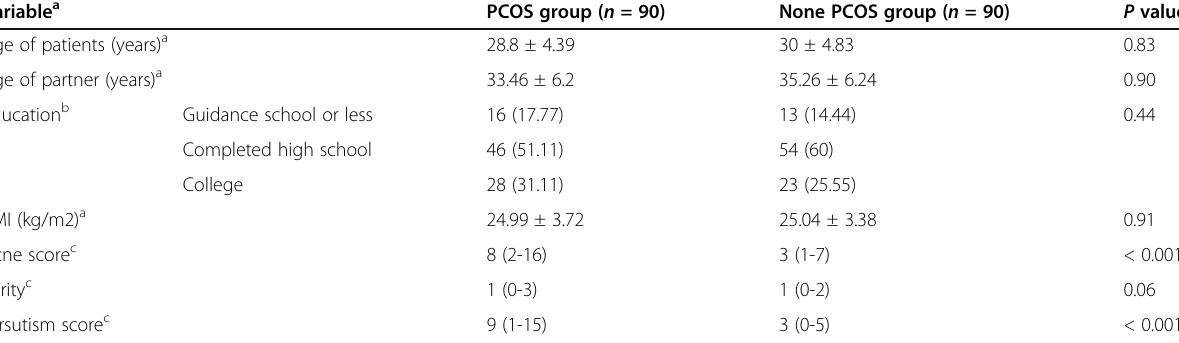
Table 1 Socio-demographic and clinical characteristics of participants Variable a